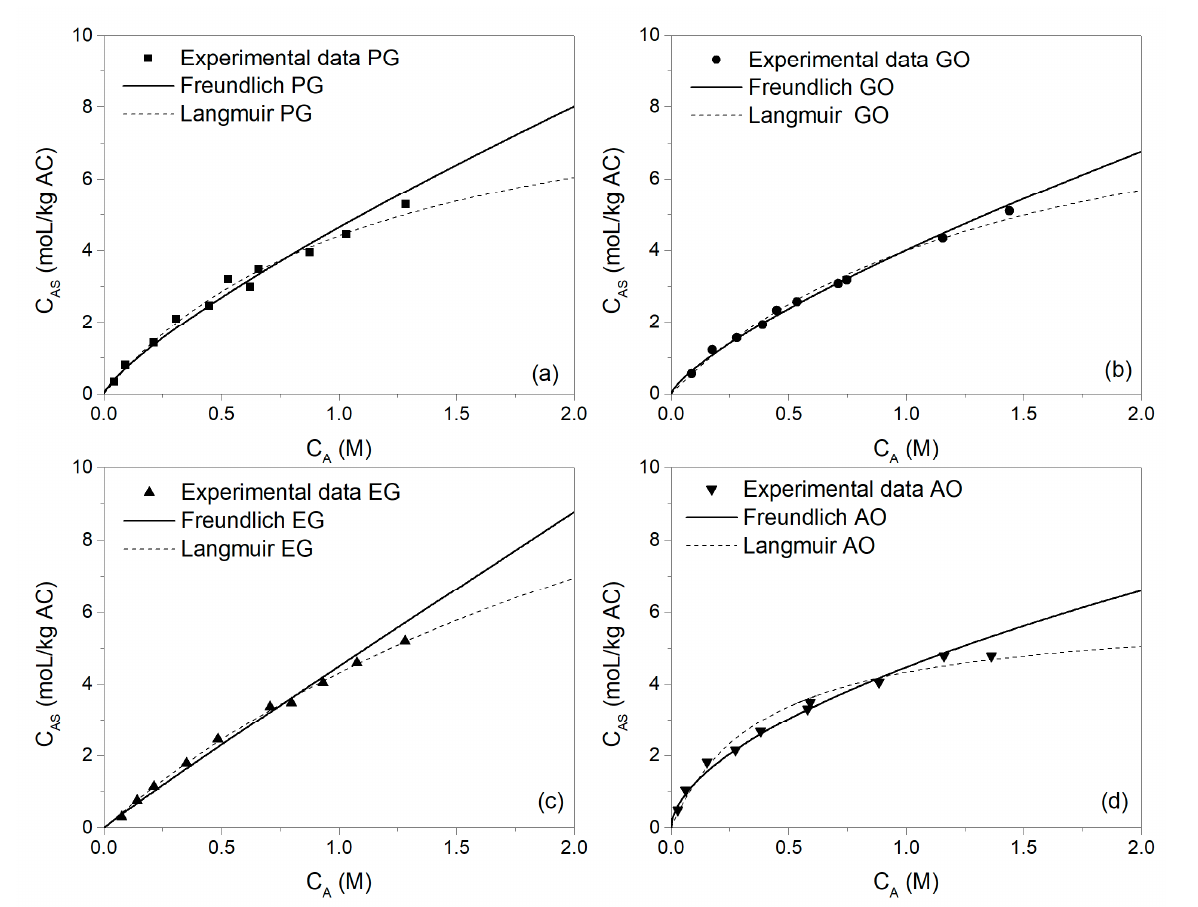
Figure 2. Adsorption isotherms for ( a ) 1,2-propanediol (PG), ( b ) glycerol (GO), ( c ) ethylene glycol (EG) and ( d ) acetol